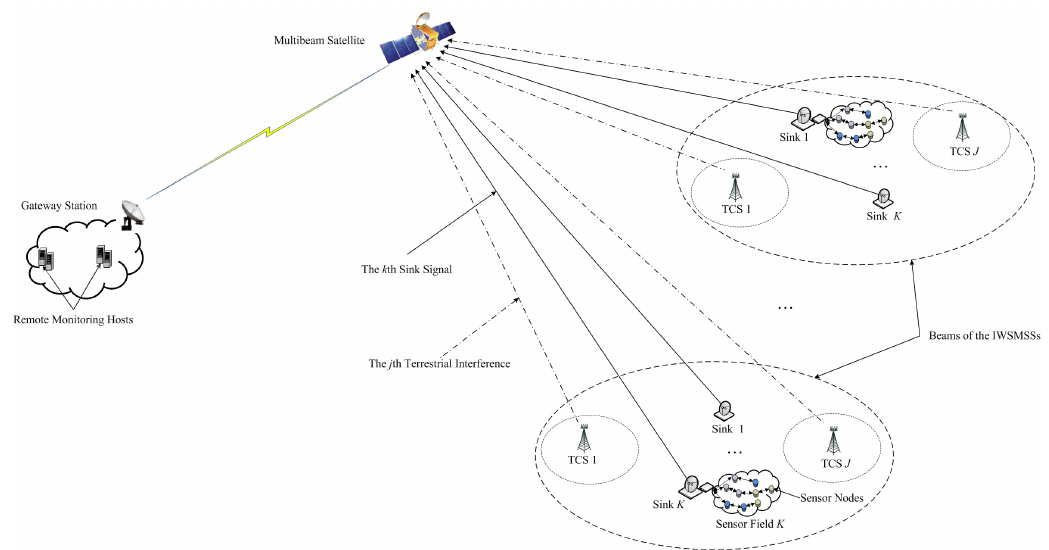
Figure 1. Integrated wireless sensor and multibeam satellite networks’